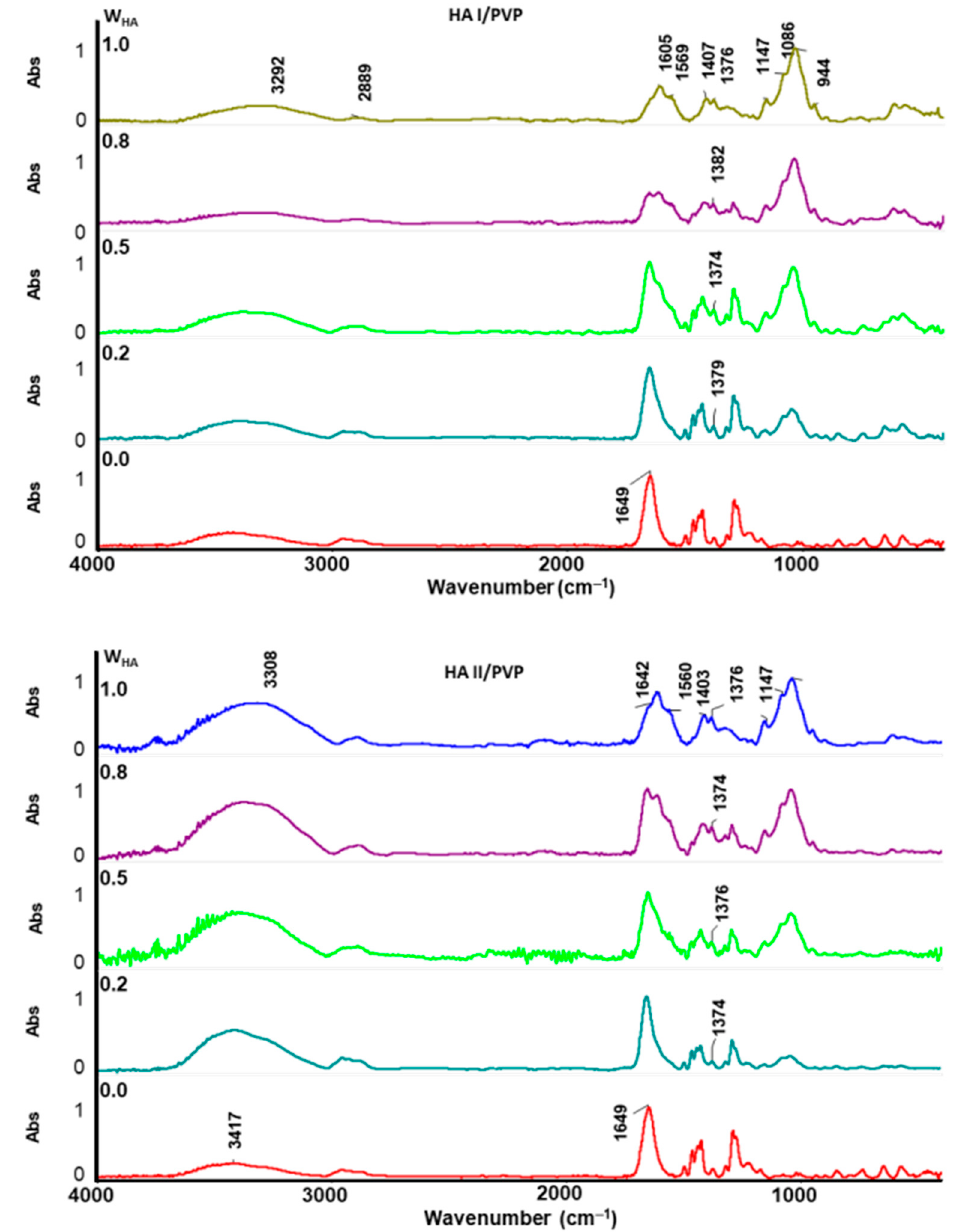
Figure 4. ATR infrared spectra of HA, PVP and HA/PVP blend films. w HA —HA weight fraction.